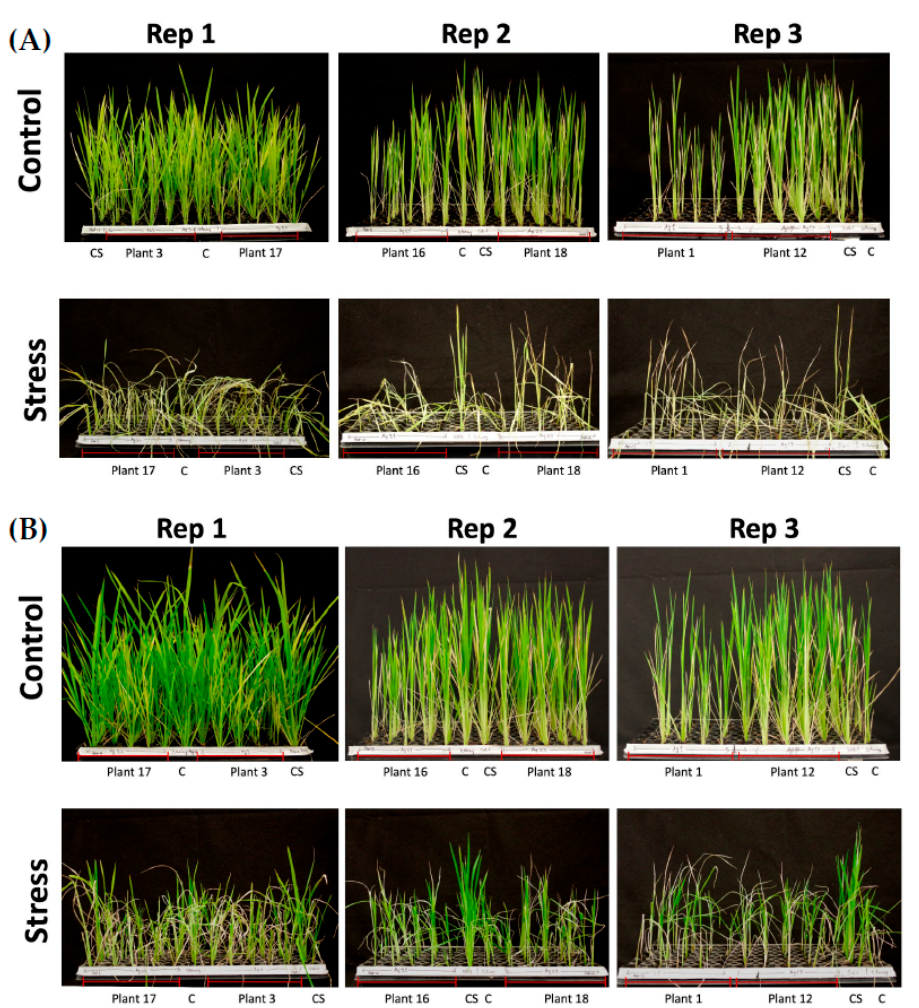
Figure 5. Performance of submerged Ciherang-Sub1, Ciherang, and T 1 seedlings compared to their corresponding controls. ( A ) Immediately after 14 days of complete submergence, and ( B ) 7 days post-submergence recovery. C, Ciherang; and CS, Ciherang-Sub1.